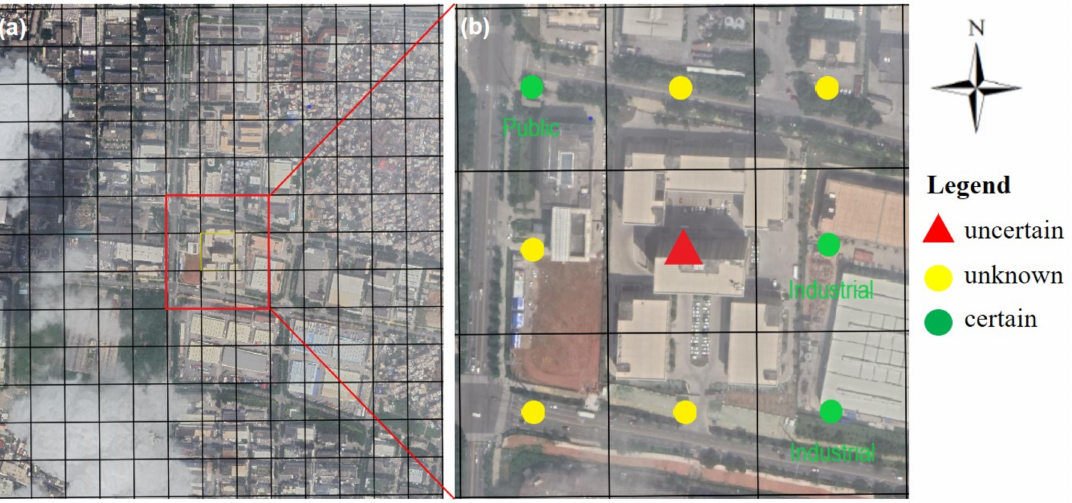
Figure 13. ( a ) Moore 3 × 3 neighborhood Representation; and ( b ) zoomed-in area of the red